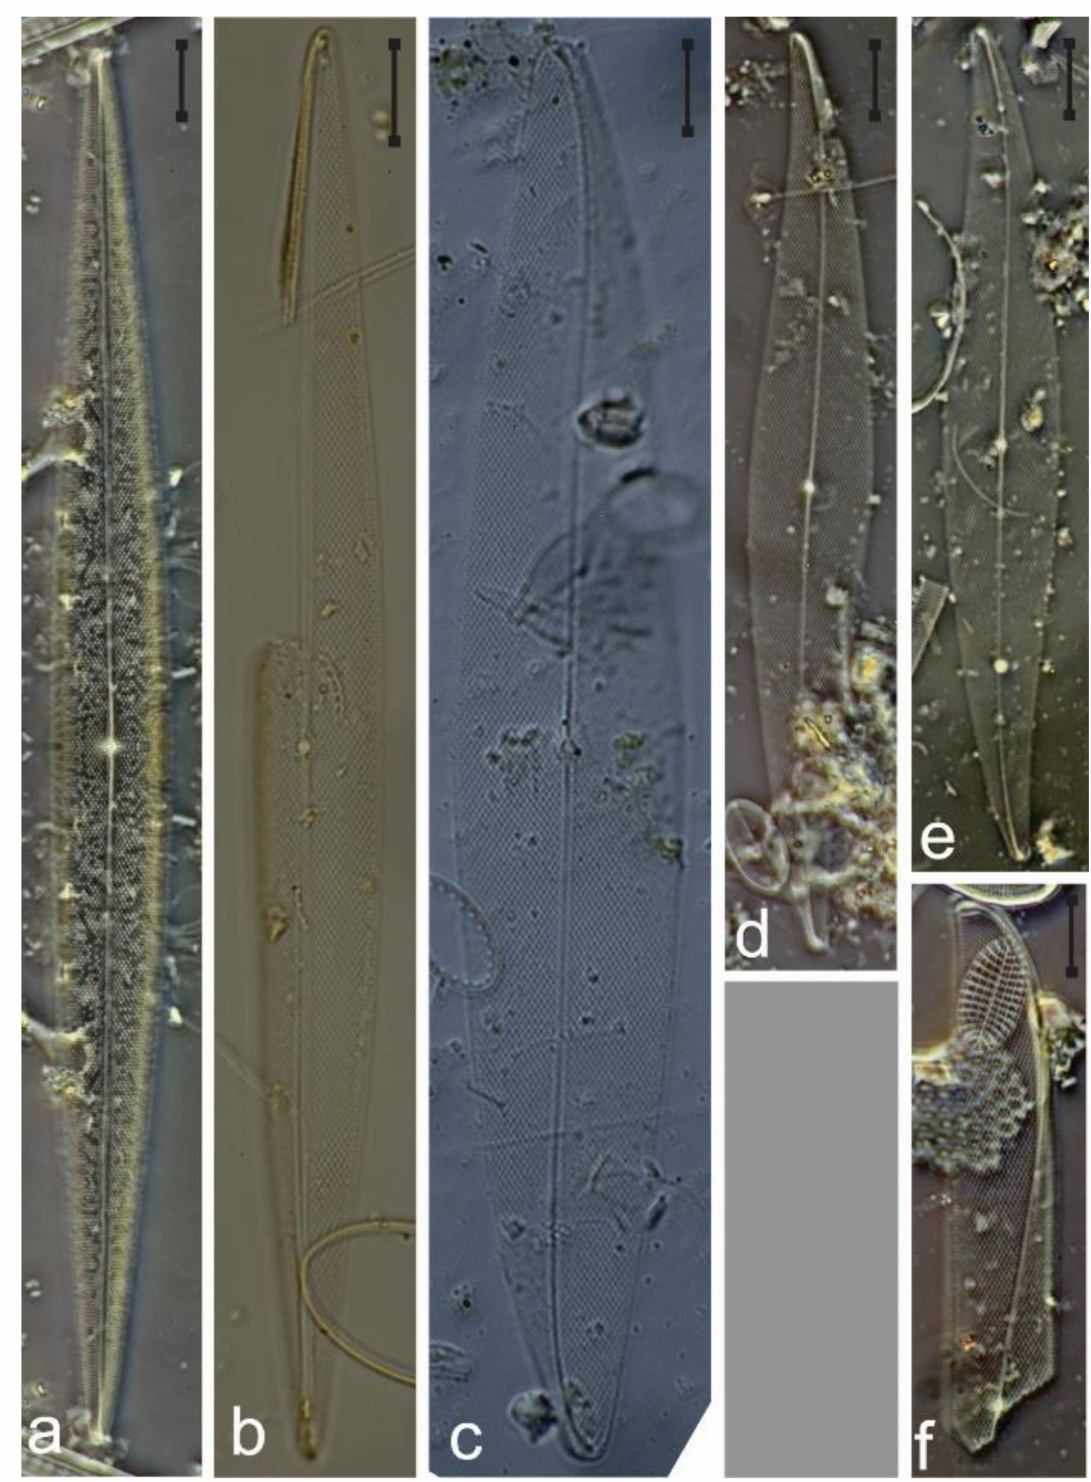
Figure 39. ( a , b ) Pleurosigma patagonicum var. paucistriatum ; ( c ) P. rigidum ; ( d , e ) P . cf. gracile ; ( f ) P. subsalinum . Scale bar = 10 µ